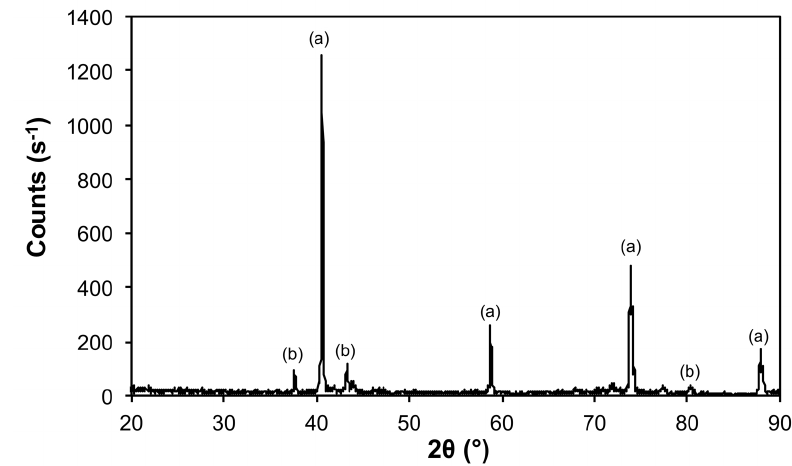
Figure 12. X-ray diffraction (XRD) of the products from the thermal decomposition of 1 under 50% H 2 (Ar balance) at 1200 °C with crystalline phases (Table 3) indicated: (a) Mo and (b) Mo 5.08 Fe 7.92 .